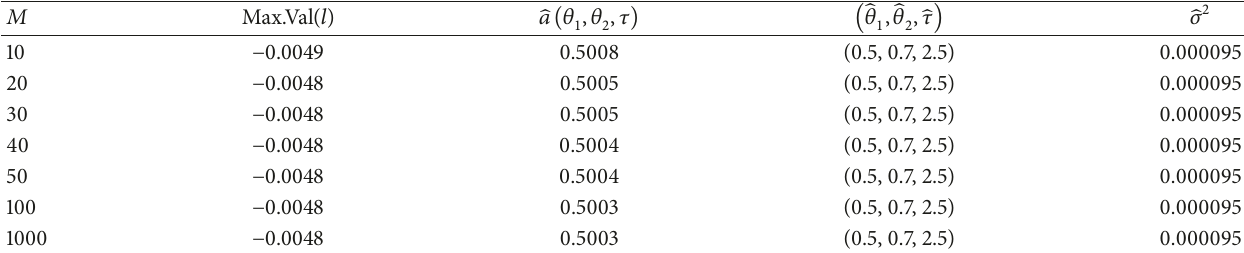
̂𝑎(̂𝜃 , ̂ 𝜃 , ̂𝜏) , ( ̂ 𝜃 , ̂ 𝜃 , ̂𝜏) , and ̂𝜎 2 for the DLDEM with single delay by using an adaptive grid. Here, 1 2 1 2